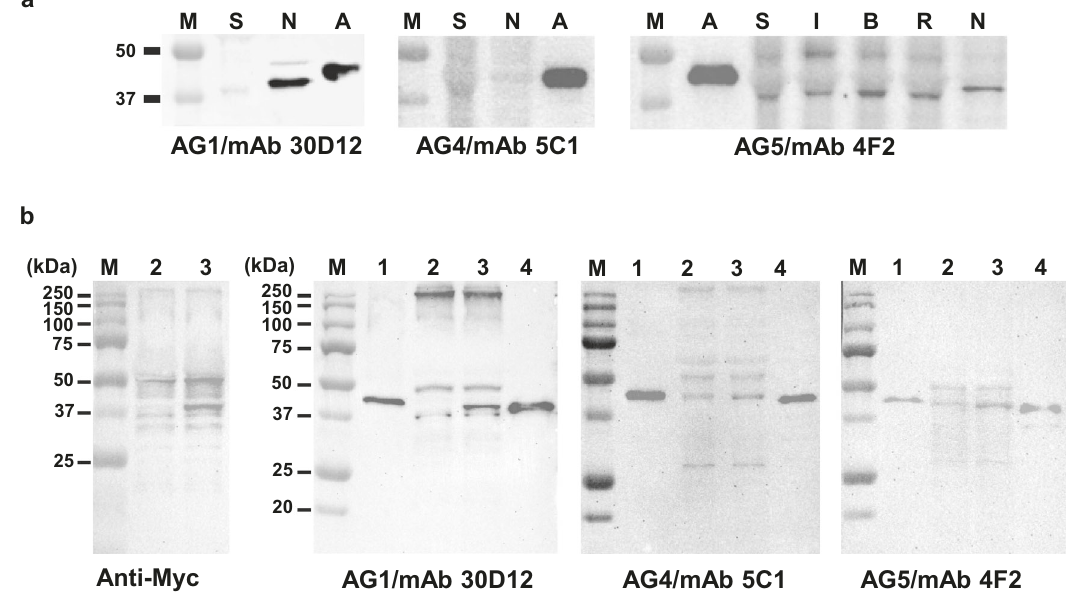
Fig. 5 Antibody validation by western blotting. a Recombinant hANKRD1 (A; 10 ng per well) and total protein (50 µ g per well) isolated from whole-cell lysates of adult rat heart tissue (Sham, S), myocardial infarcted Day 2 tissue (infarcted region, I; border region, B; remote region, R) and neonatal rat cardiomyocytes (N), were separated by SDS-PAGE, transblotted onto PVDF membranes and probed with antibody indicated below each panel. M, All-Blue Precision Protein Standards (BioRad) showing only the 50 and 37 kDa marker bands. b Western blot analysis of lane 1. puri fi ed recombinant hANKRD1 (Origene Technologies, 4 ng/well); lane 2. lysate from pCMV-Myc transfected H9c2 cells; lane 3. lysate from pCMV-Myc/hANKRD1-transfected H9c2 cells; lane 4. lysate from E. coli cells expressing hANKRD1, probed with antibodies indicated at the bottom of each panel. Total protein loading for H9c2 and E. coli lysates were 20 µ g per